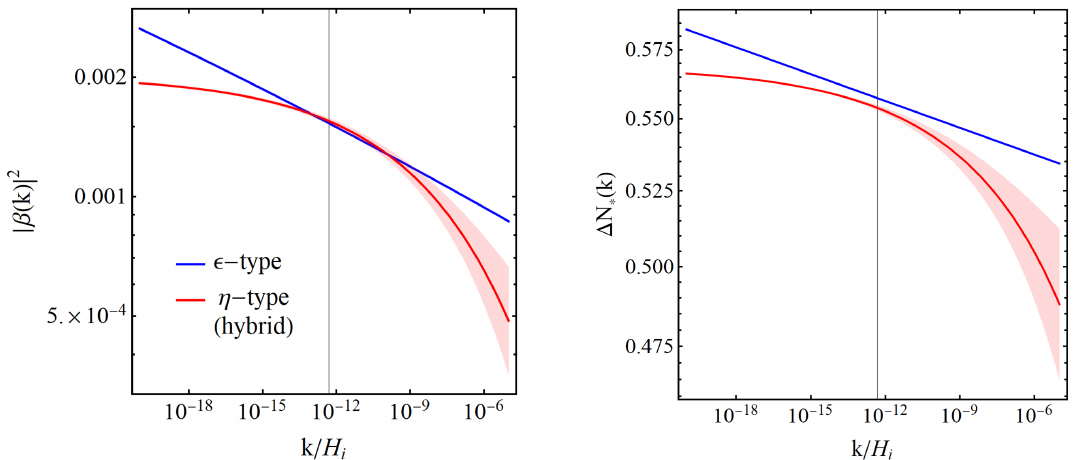
Figure 18 . The scale dependence of production amount and width for the two spacetimes in figure 17. The opaque bands stand for the higher-order errors present in (4.36), (4.40), (4.54) and (4.58). Notice that the error band for (cid:15) -type is too thin to be observed. The vertical black line indicates the mode k 0 = − τ − 1 . The other parameters are chosen to be m = 10 H i , κ = 9 H i 0